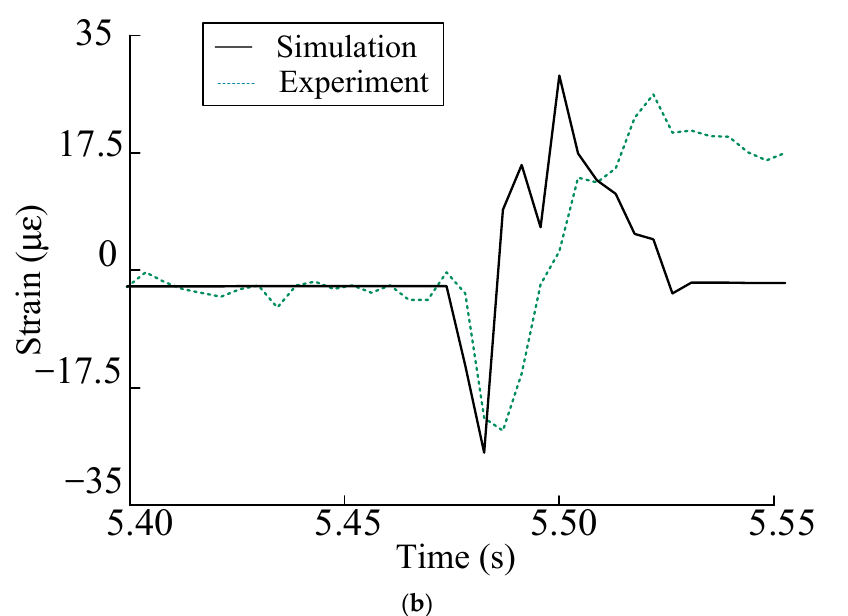
Figure 12. ( a ) Simulation and experiment signal time domain history. ( b ) Enlarged diagram of the meshing area.